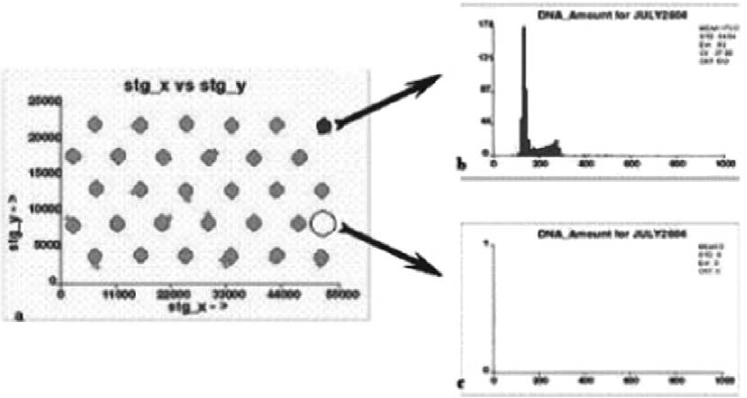
Fig. 9. An example of a slide prepared by our automated depositing device, stained by quantitative Feulgen staining technique, scanned by the Oncometrics Imaging Company Cyto-Savant automated data analysis system, and analyzed by in house developed software (a). The “+” sign is used by the software to indicate the presence of a single scanned cell. It can be seen that the cells tends to stay in close proximity of their deposited spot. The histogram of the DNA amount of one of the spots is shown in (b). The DNA amount of the blank spot is shown in (c), zero DNA amount is recorded as